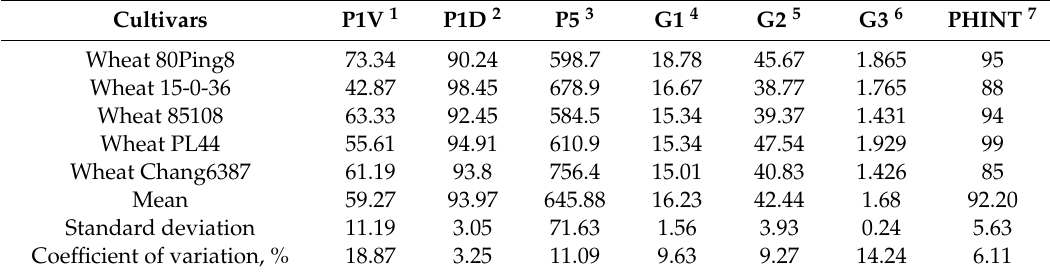
Table 2. Genetic parameter definition and calibrated values for wheat in this study.